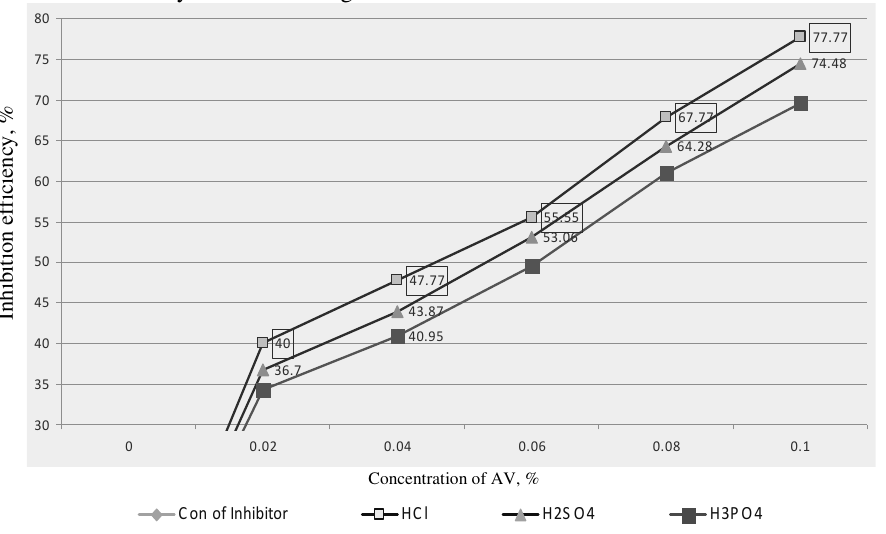
Figure 1. Effect of inhibition efficiency of AV on mild steel corrosion in different acid medium (1 h duration )